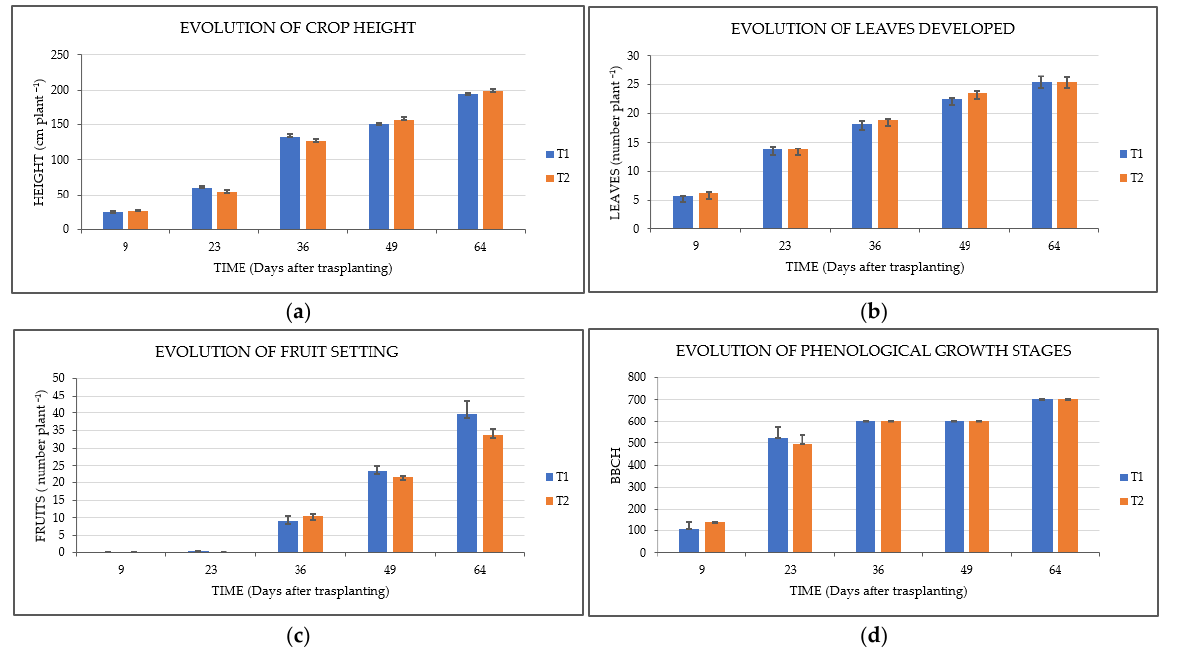
Figure 4. Growth parameters of tomato crops grown in soil: ( a ) evolution of crop height; ( b ) evolu- tion of leaves developed; ( c ) evolution of fruit setting; ( d ) evolution of phenological growth stages.